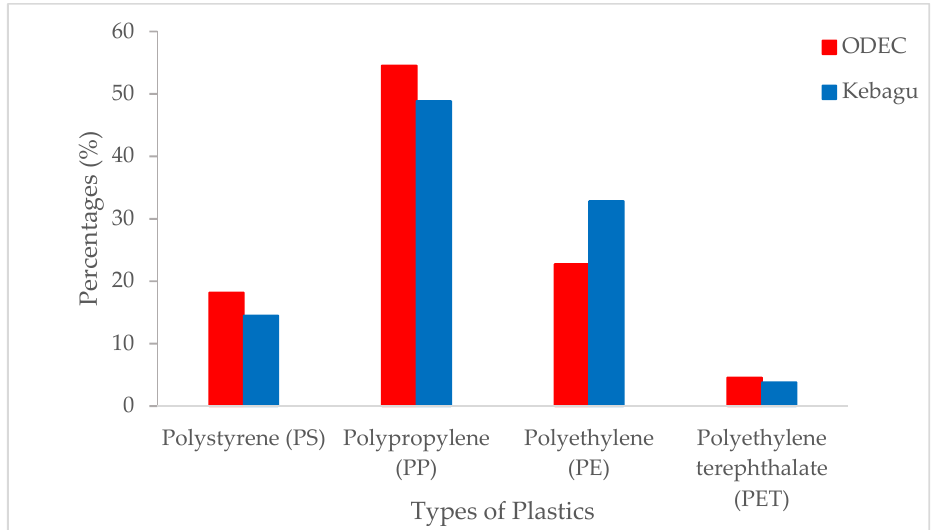
Figure 8. Percentages of plastic fragments pooled from ODEC and Kebagu beaches, from FTIR anal- ysis .